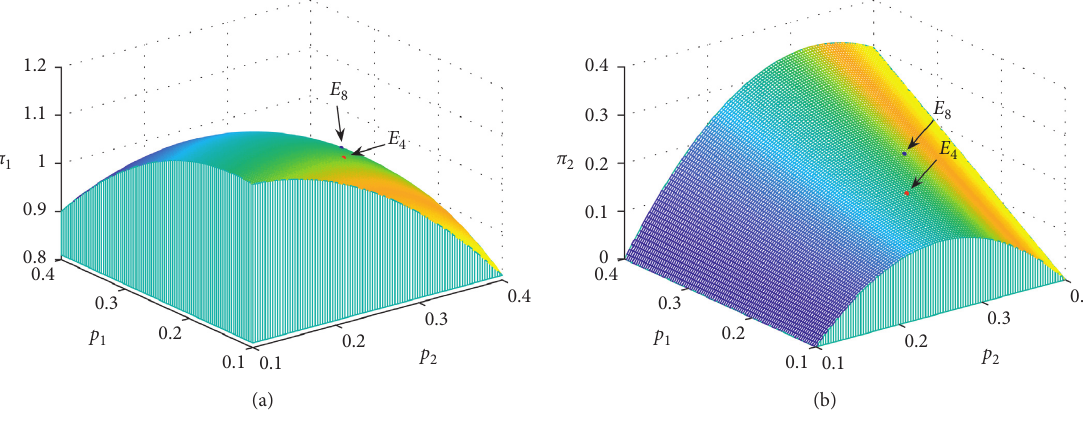
Figure 8: The welfare of IC